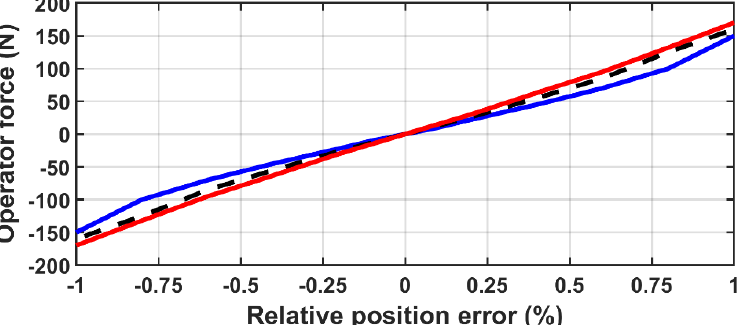
Figure 10. Diagram of correlation between the operator force and relative position error: solid line for m = 200 kg, dashed line for m = 150 kg, dotted line for m = 100 kg.